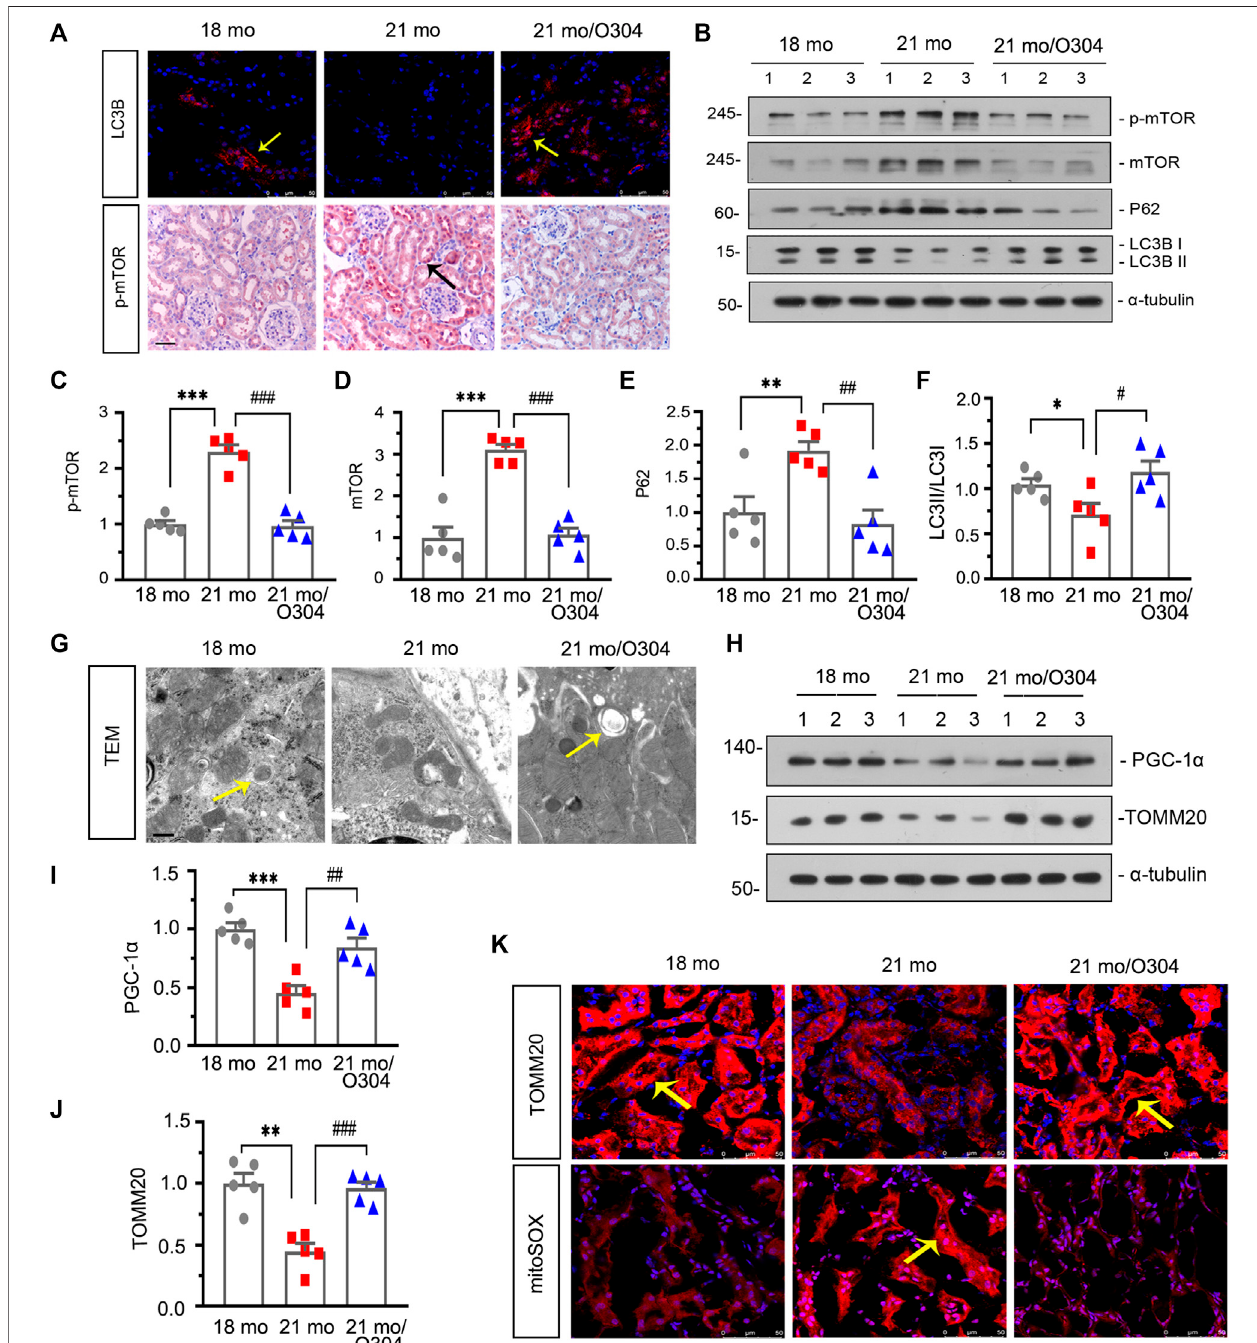
FIGURE 6 | O304 could promote autophagy and alleviate mitochondrial dysfunction in naturally aging mice. (A) Representative micrographs showing LC3B (top) and p-mTOR (bottom) expression in kidneys in different groups. Cryosections were subjected to fl uorescence staining for LC3B. Paraf fi n-embedded kidney sections were immunostained with an antibody against p-mTOR. Arrows indicate positive staining. scale bar, 50 μ m. (B – F) Representative western blot and quantitative data showing renal expression of p-mTOR, mTOR, P62 and enhanced LC3-II formation in different groups. Numbers (1 – 3) indicate each individual animal in each given group. * p < 0.05, ** p < 0.01, *** p < 0.001 versus 18-month-old mice group. # p < 0.05, ## p < 0.01, ### p < 0.001 versus 21-month-old mice group alone ( n = 5). (G) Representative transmission electron microscopy (TEM) micrographs show autophagic vacuole in different groups in ultrathin kidney sections. Arrow indicates autophagic vacuole.Scale bar, 0.5 μ m. (H – J) Representative western blot and quantitative data showing renal expression of PGC-1 α and TOMM20 in different groups. Numbers(1 – 3)indicate eachindividualanimalineachgivengroup. ** p < 0.01,*** p < 0.001versus18-month-oldmicegroup. ## p < 0.01, ### p < 0.001versus21-month- oldmicegroupalone ( n =5). (K) RepresentativemicrographsshowingtheexpressionofTOMM20(top)and mitochondrialROSbymitoSOXstaining(bottom) inkidneys in different groups. Cryosections were subjected to fl uorescence staining for TOMM20 and mitoSOX. Arrows indicate positive staining.